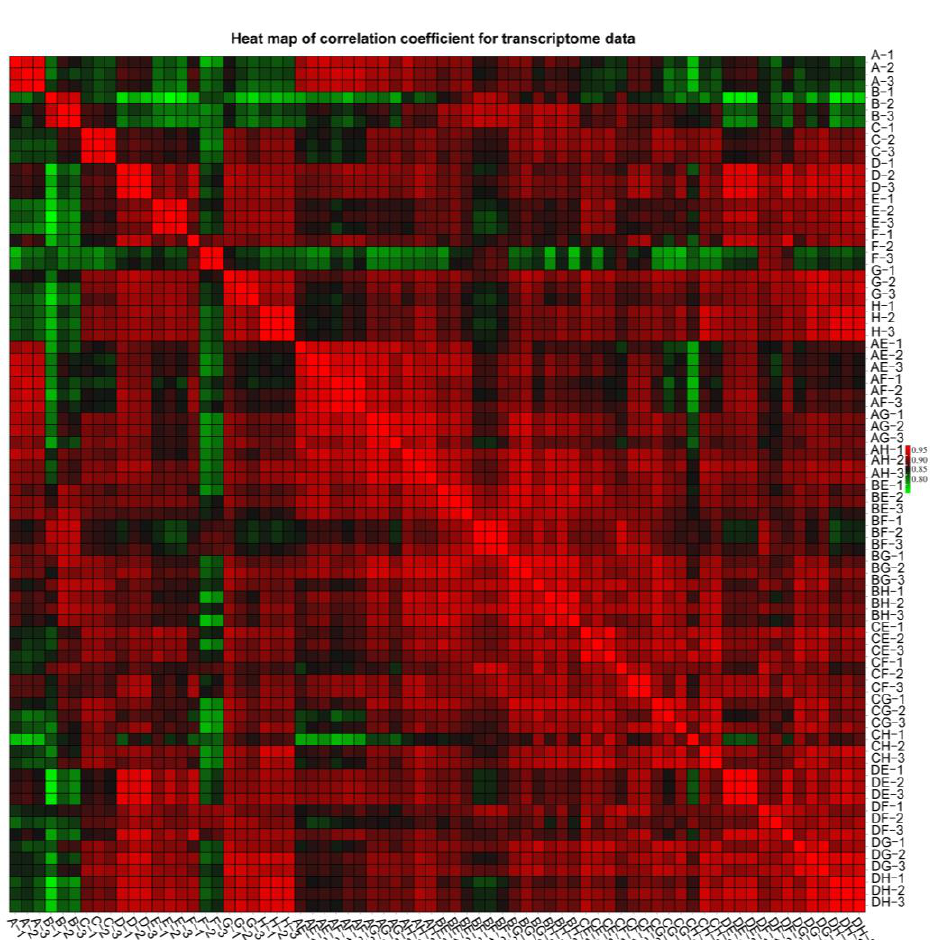
Figure 1. Heat map of correlation analysis based on transcriptome data in all transcripts. Table 1. Quantity statistics of differentially expressed genes.